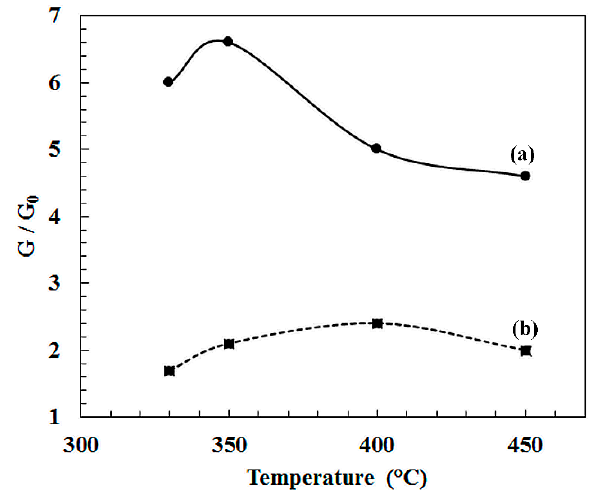
Figure 7. Sensitivity of sensor-400 (a) and sensor-500 (b) under 100 ppm of H 2 S in air as a function of temperature [19].